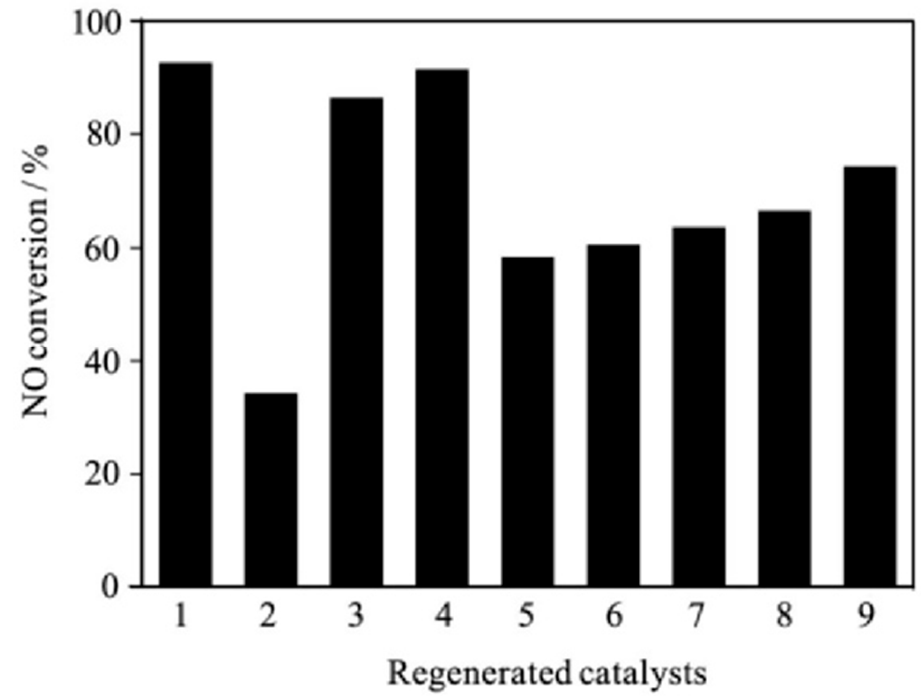
Figure 31. SCR activities of fresh Mn-Ce/TiO 2 (0.075) (1), deactivated sample (2), and regenerated